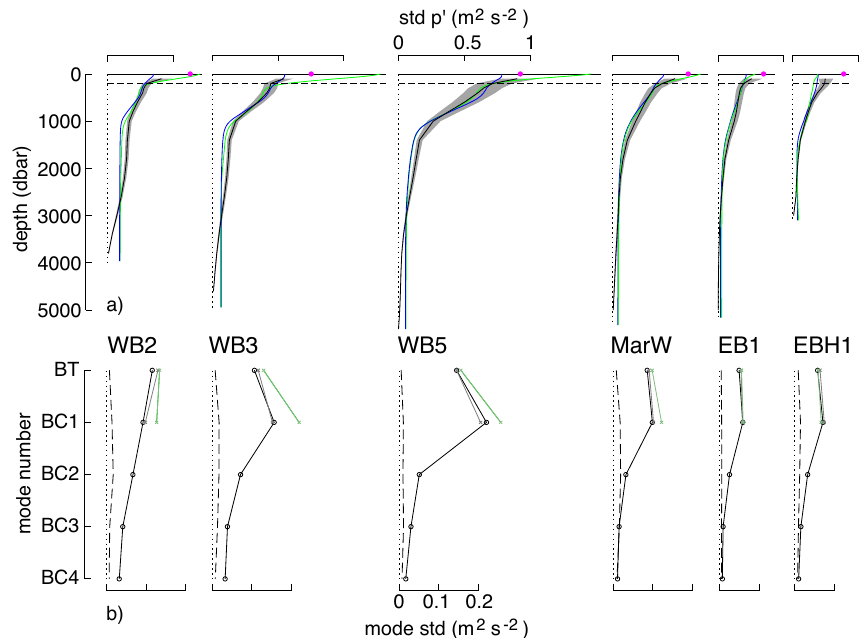
Fig. 6. (a) The standard deviation (std) of p 0 against depth, for the direct observations (black) and 95% confidence limits calculated with the F-statistic (gray), the flat-bottom M = 2 reconstruction (blue), the KB M = 2 reconstruction (green), and SSH (pink). (b) Standard deviation against mode number of P n multiplied by the vertical rms of F n , for the complete M = 5 flat-bottomed modes (black), the flat-bottom M = 2 modes (gray), and the KB M = 2 modes (green). The dashed black line is the average error from the Gauss-Markov inversion for the complete M = 5 flat-bottom decomposition. The moorings are offset arbitrarily and are ordered from west to